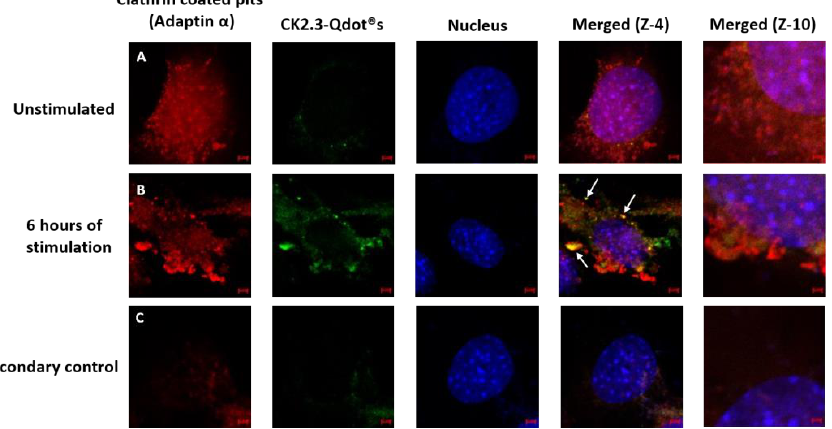
Figure 9. Mechanism of endocytic uptake of CK2.3-Qdot® s. ( A ): C2C12 cells were either left untreated or ( B ): treated with 100 nM of CK2.3-Qdot® s for 6 h. Later the cells were fixed and the nucleus (blue)